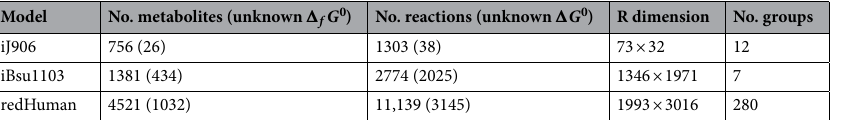
Table 2. Properties of the investigated genome-scale metabolic models. Shown are the number of metabolites and the number of those with unknown ∆ f G 0 , the number of reactions and the number of those with unknown (cid:31) G 0 , the dimensions of the matrix R of reactions used in the lumping procedure, and the number of metabolite groups.